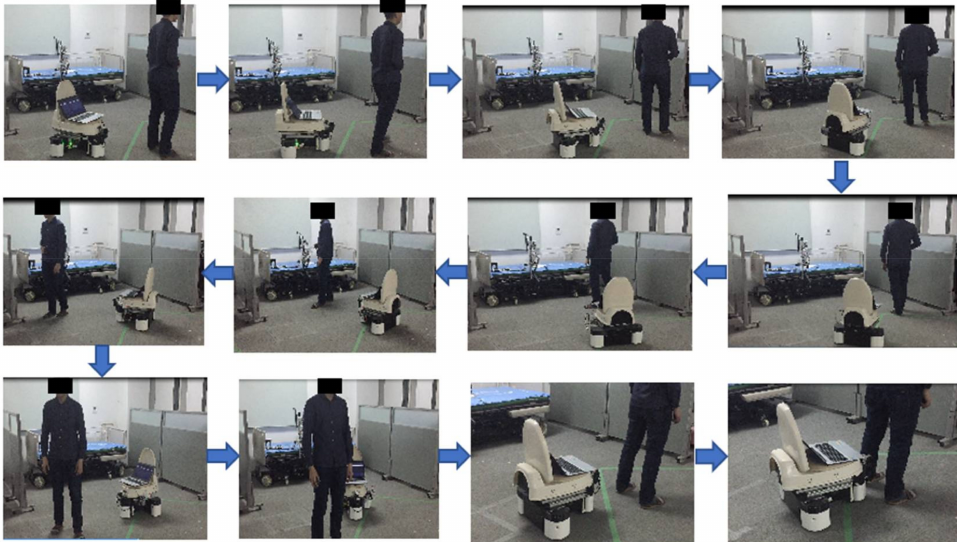
Figure 13. The path-tracking experiment for a complex path in an indoor environment.